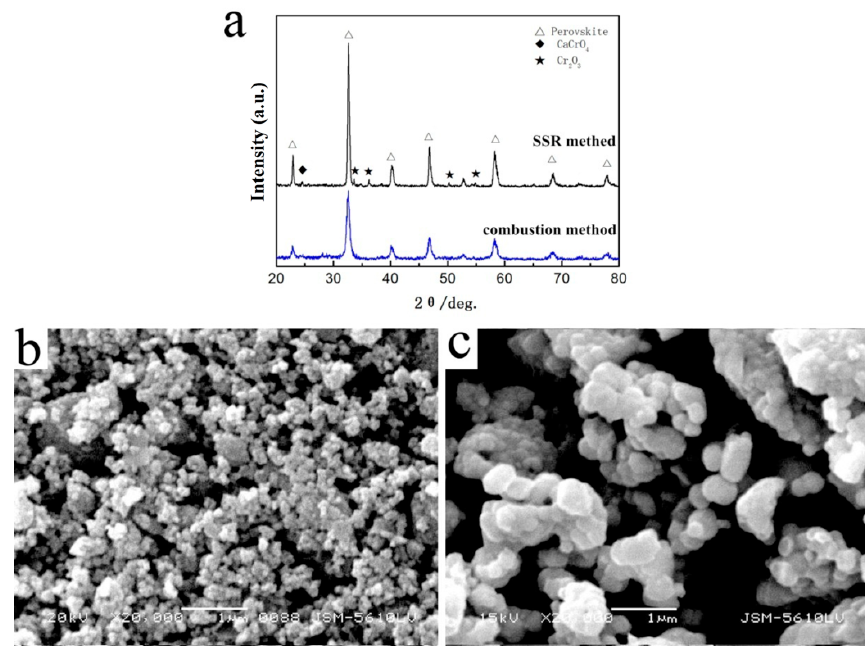
Figure 1. ( a ) XRD patterns and SEM images of La 0.8 Ca 0.2 CrO 3 powders synthesized by ( b ) the combustion method and ( c ) the conventional solid state reaction (SSR) method, respectively.